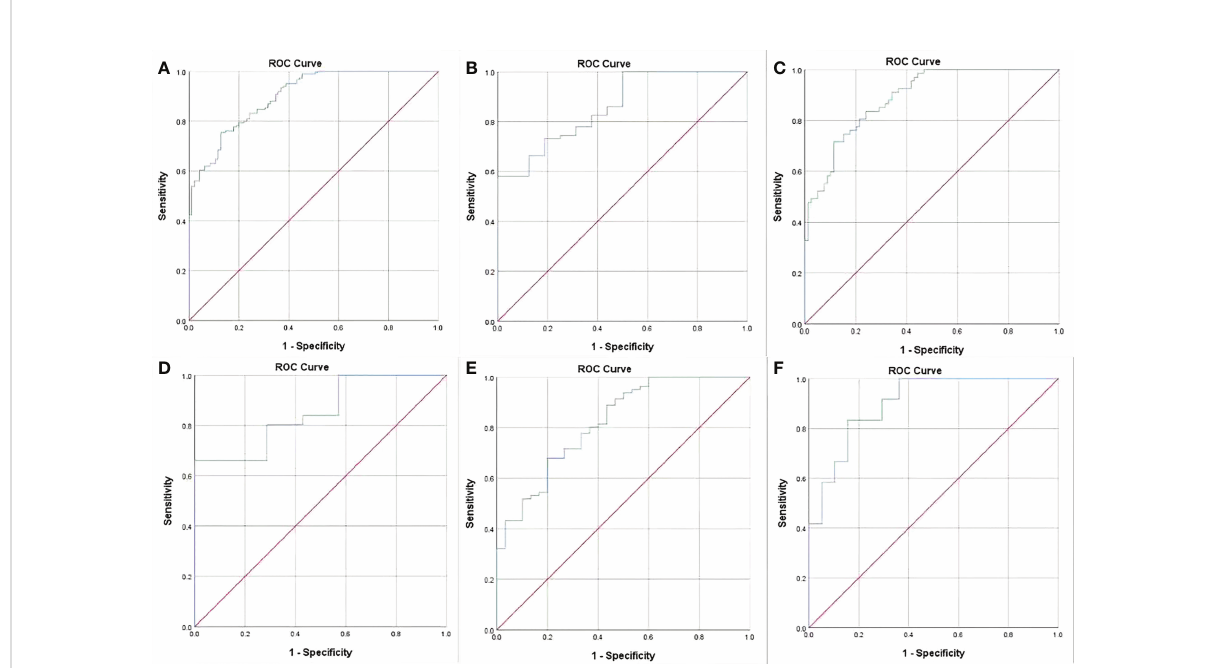
FIGURE 2 Receiver operating characteristic (ROC) analysis of gross tumor volume (GTV) of adenocarcinoma of the esophagogastric junction has been performed for determining resectability, and the ROC curves show that the GTV can help identify whether the tumor can be resectable in stages cT 1-4 N 0-3 (A) with the cutoff values of 32.77 cm 3 , especially in stages cT 3 (B) and cT 4 (C) , or stages cN 1 (D) , cN 2 (E) and cN 3 (F) with the threshold values of 27.67 and 32.77 cm 3 , or 27.09, 33.32 and 37.39 cm 3 ,